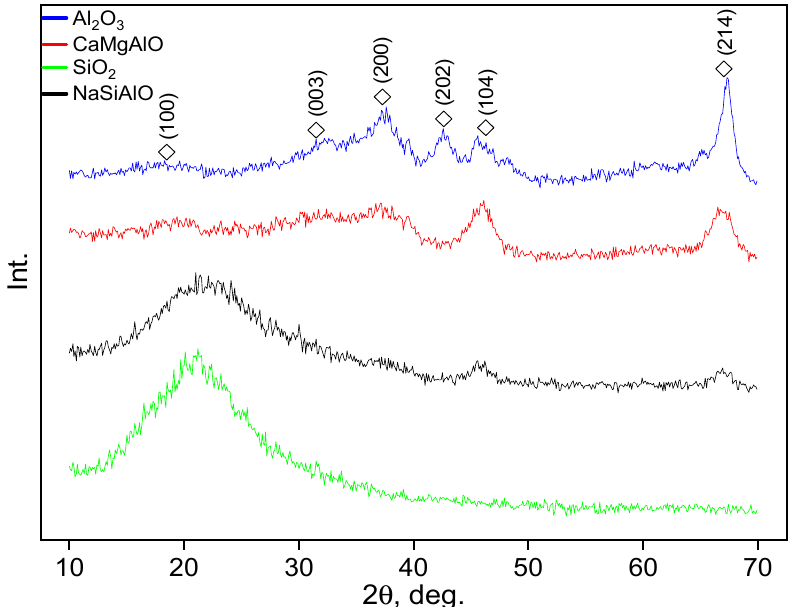
Figure 2. Diffractograms of the supports. The figure contains the reference reflexes of the phase γ -Al 2 O 3 shown as M: the ICDD card number [00-013-0373].